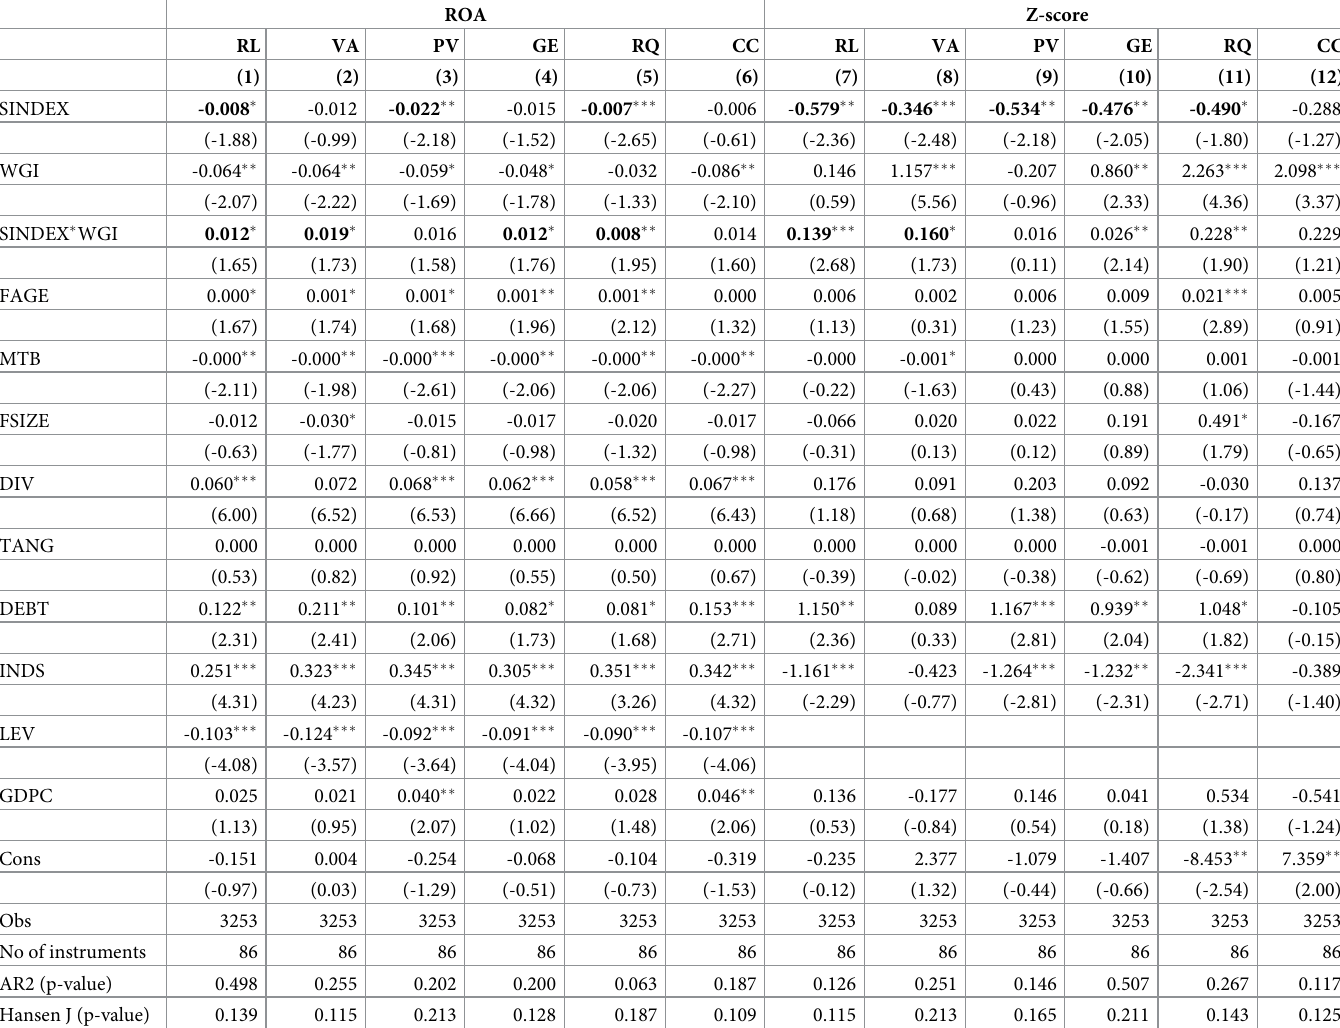
Table 12. Robustness test results using system GMM and components of country governance